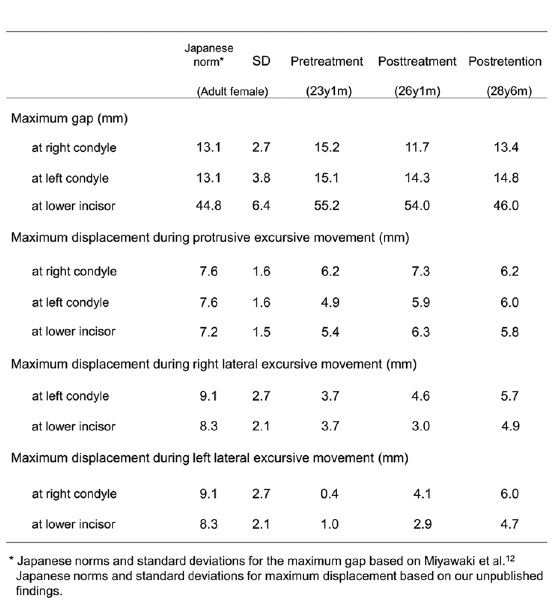
Table II. Maximum gap and displacement from the centric occlusion at each